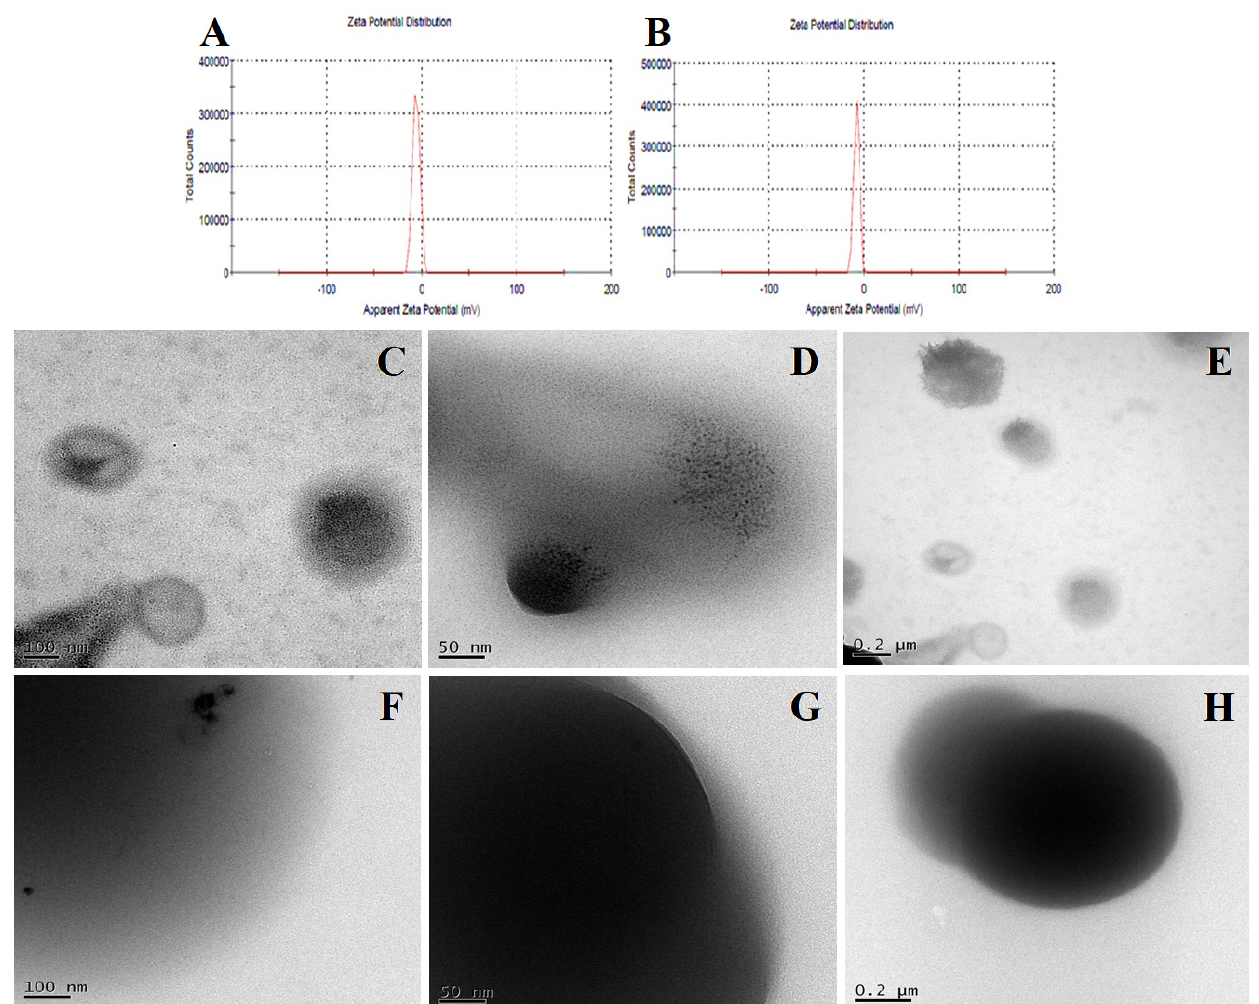
Figure 4. DLS size-distribution plot and cryo-TEM images of the SDA/KM ( A , C , D , E ) and SDC/ELV ( B , F,G , H ).